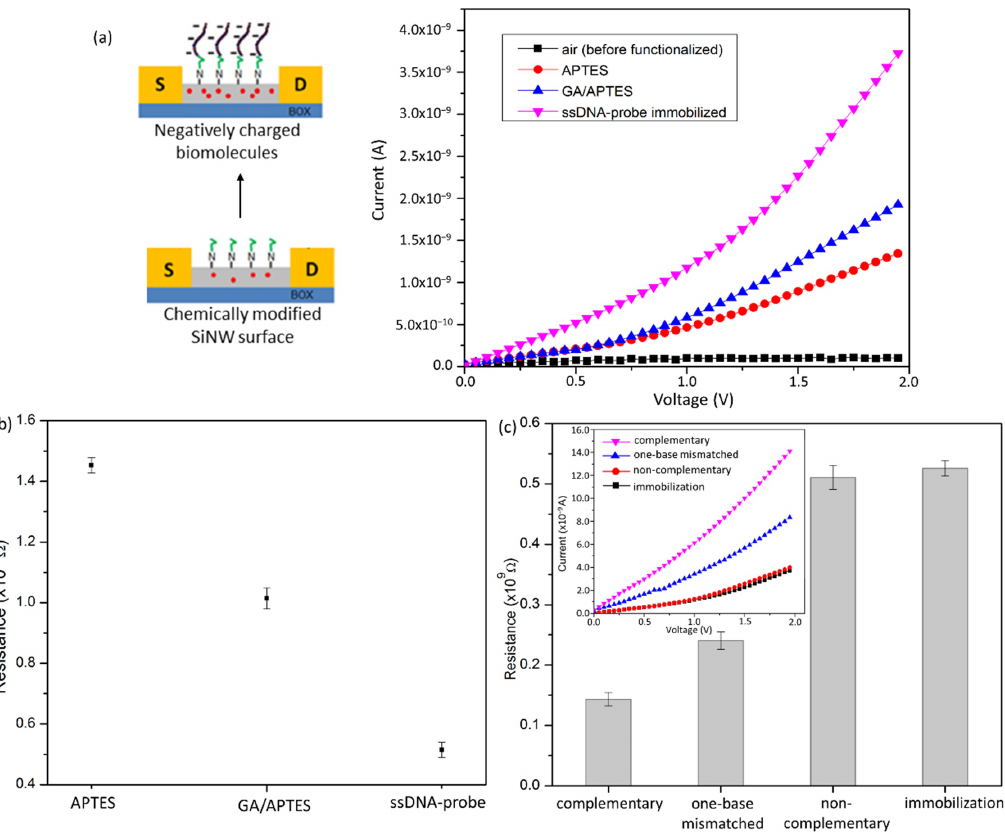
Figure 7. ( a ) Schematic illustration of p-type SiNW detection scheme ( left ) and electrical measurement of the different step-functionalized SiNW sensors ( right ). ( b ) The resistance measurement at V ds = 2V of the fabricated device is plotted with respect to the different stages of surface functionalization. ( c ) Selectivity studies of developed ssDNA-based SiNW sensors towards different target DNA (complementary, one-base mismatched, and